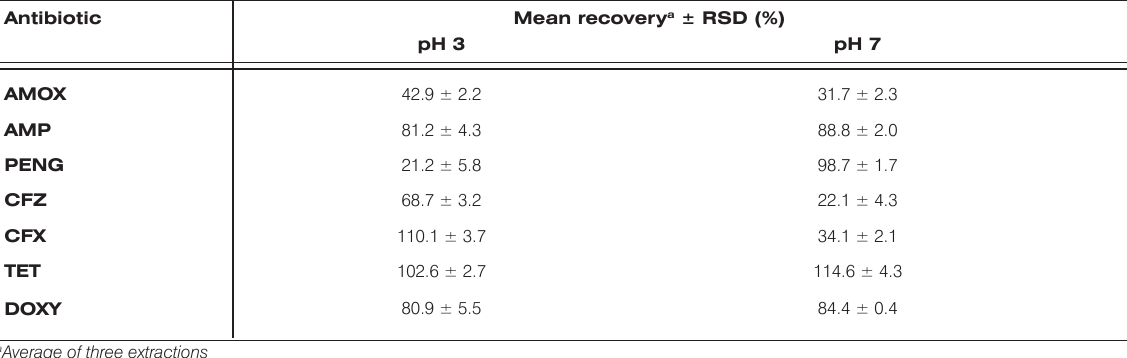
Table 2. Mean recovery rates for the selected antibiotics with the relative standard deviations, at pH 3 and 7.